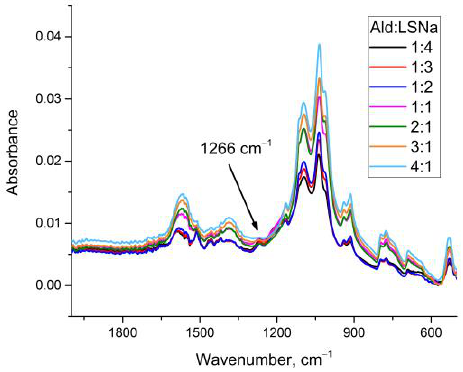
Figure 2. ATR absorption spectra of aqueous solutions of Aldrich HS and LSNa mixtures of different compositions (total concentration of components, 100 g/L) in the range of 2000–500 cm −1 .